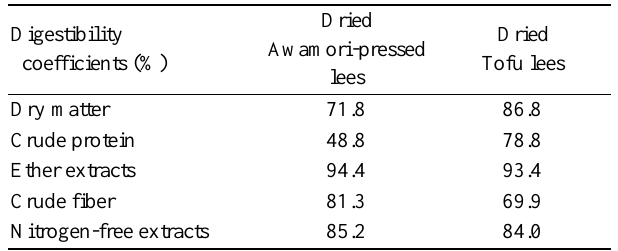
Table 2. Digestibility coefficients of dried Awamori-pressed lees and dried Tofu lees in adult goats Digestibility